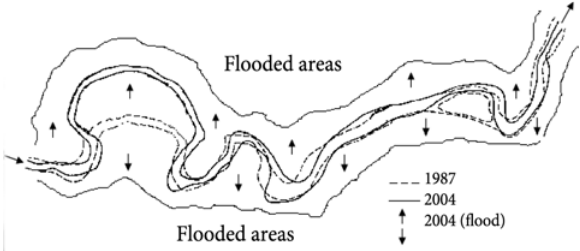
Fig. 7. Stream channel configuration after dam construction and flood areas (canal configuration in 1987 (dashed line) and 2004 (solid line) of Goksu